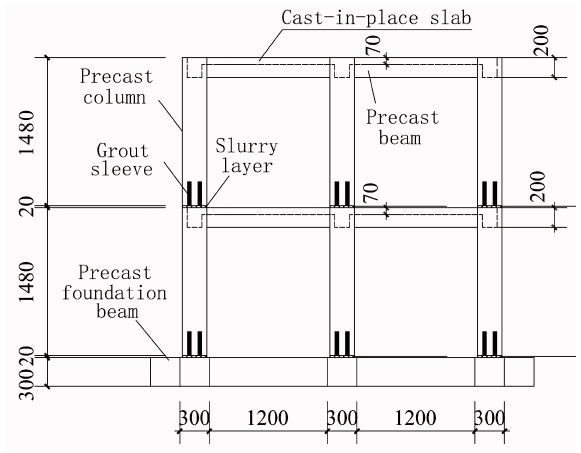
Figure 14. Elevation of the precast concrete frame structure (unit: mm).